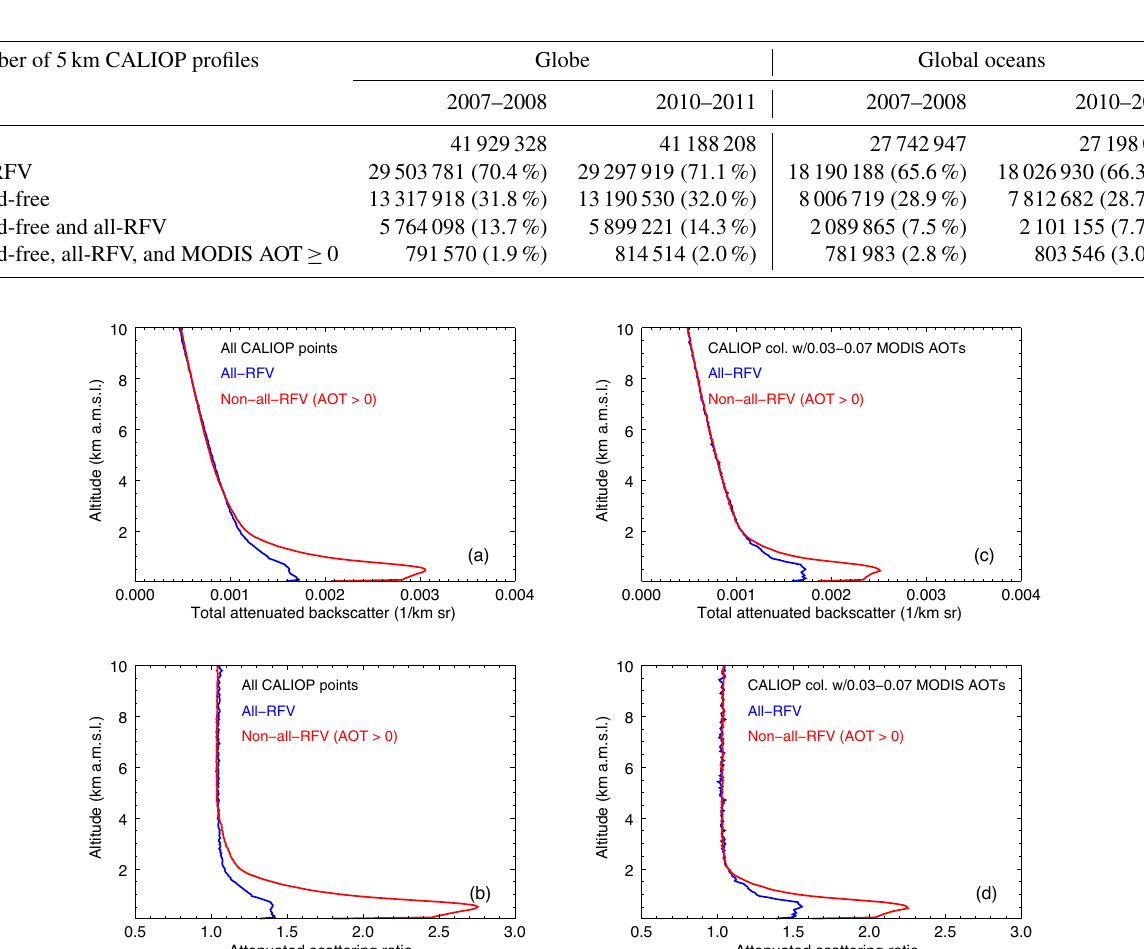
Figure 2. For February 2008, mean profiles of (a, c) level 1.5 total attenuated backscatter (TAB) and (b, d) attenuated scattering ratio (TAB/molecular attenuated backscatter) over global oceans, corresponding to level 2 all-RFV (in blue) and non-all-RFV (AOT > 0; in red) profiles. The left column is from an analysis of all cloud-free CALIOP points over global oceans and the right column represents only those collocated with MODIS AOTs between 0.03 and